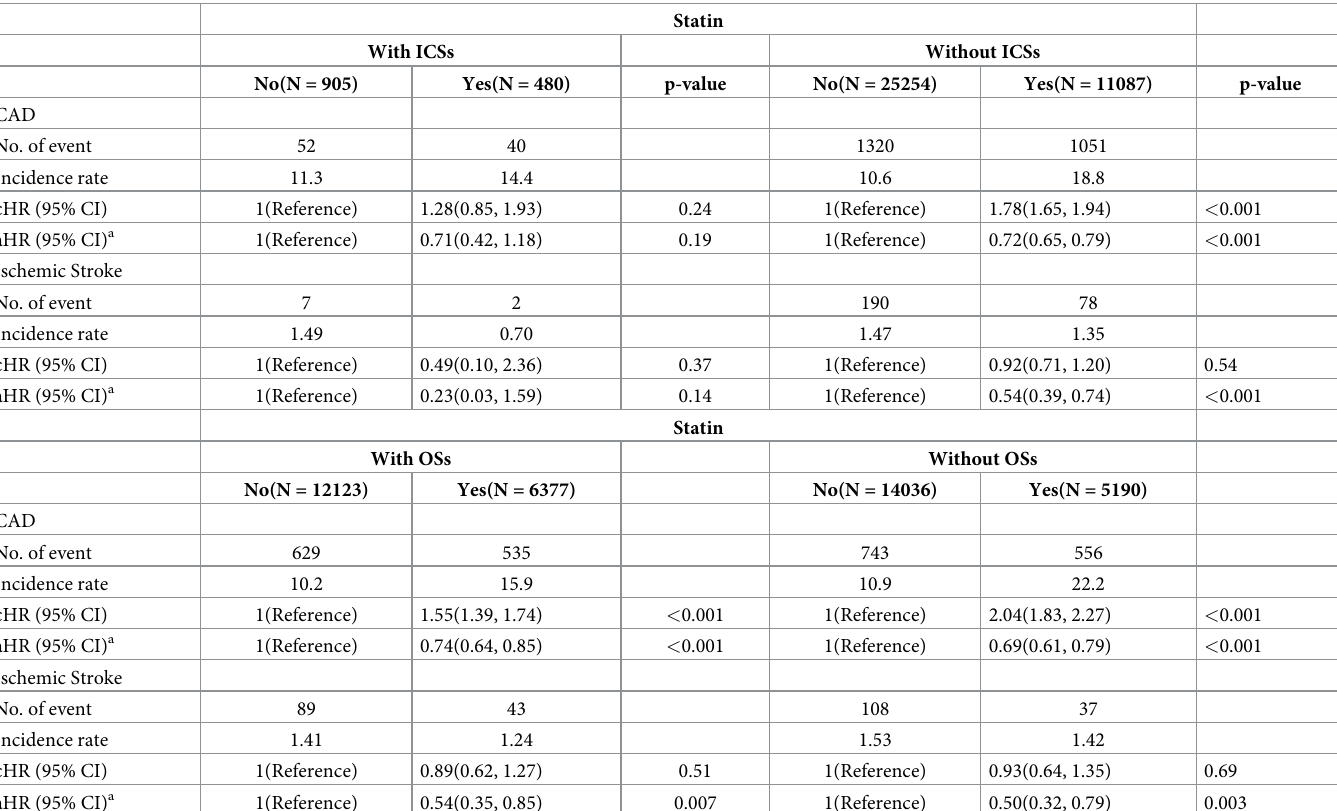
Table 4. Overall Incidence (per 1,000 person-years) and hazard ratio for coronary artery disease and ischemic stroke in interstitial lung disease and pulmonary fibrosis patients with statin compared to the interstitial lung disease and pulmonary fibrosis patients without statin by ICSs status and OSs status by time depen- dent regression